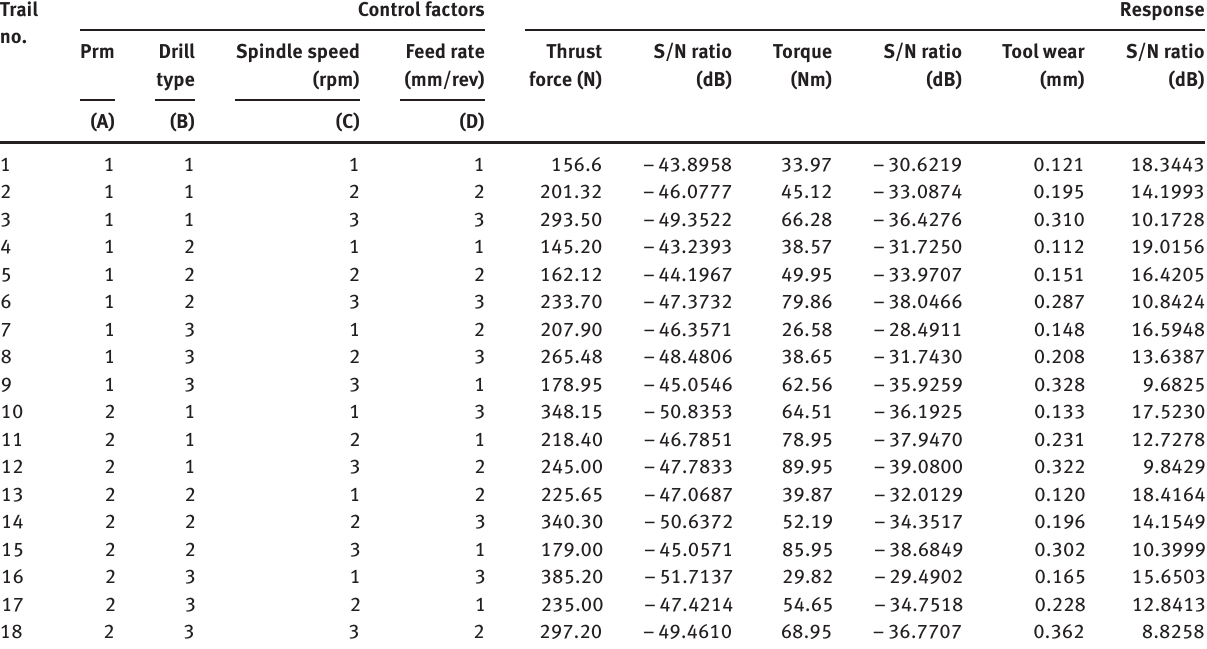
Table 4: Experimental results using L18 (2 1 × 3 3 ) orthogonal array along with S/N ratio. Trail